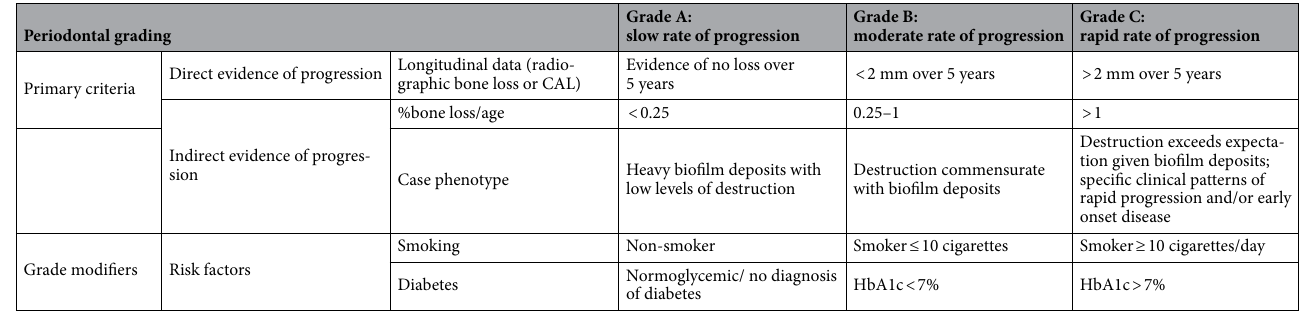
Table 2. Periodontal grading according to the new classification of AAP/EFP 3